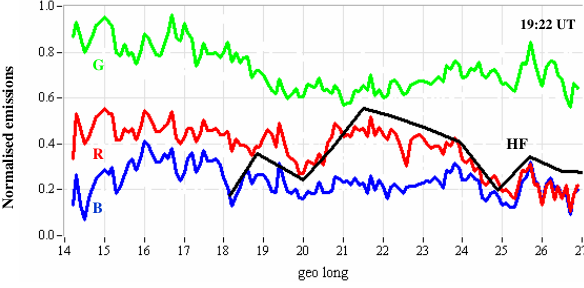
Fig. 11. Variation of r-g-b emissions and HF power along the arc.